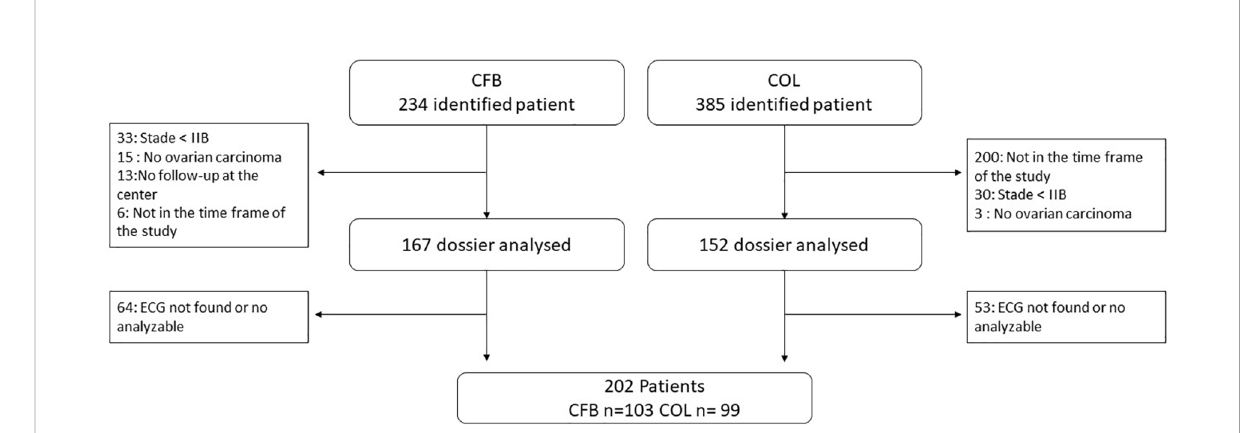
FIGURE 1 Flow chart. CFB, Francois Baclesse Center; Caen, COL; Oscar Lambret Center, Lille; ECG,